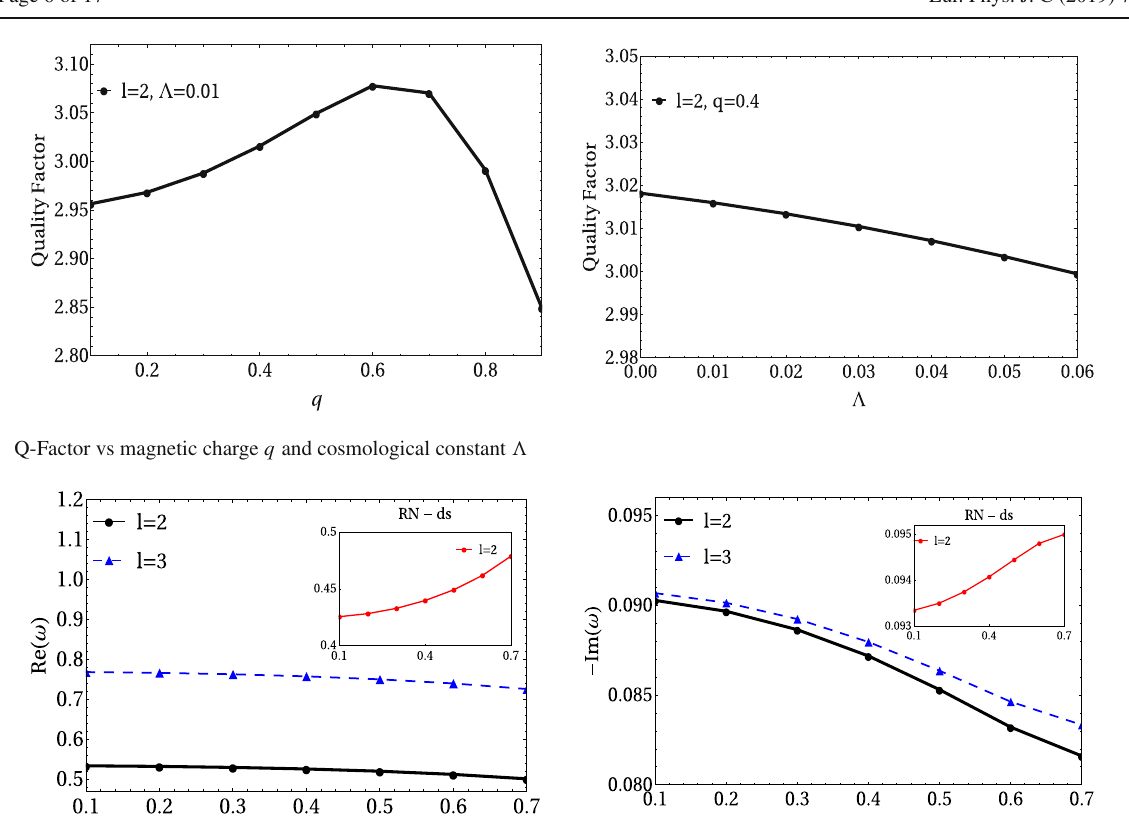
Fig. 4 Variation of Re( ω ) and -Im( ω ) vs. charge q for a fixed value of (cid:2) = 0 . 01 for BdS black holes. The inset shows the same plott for RN-dS with the same values of the parameter